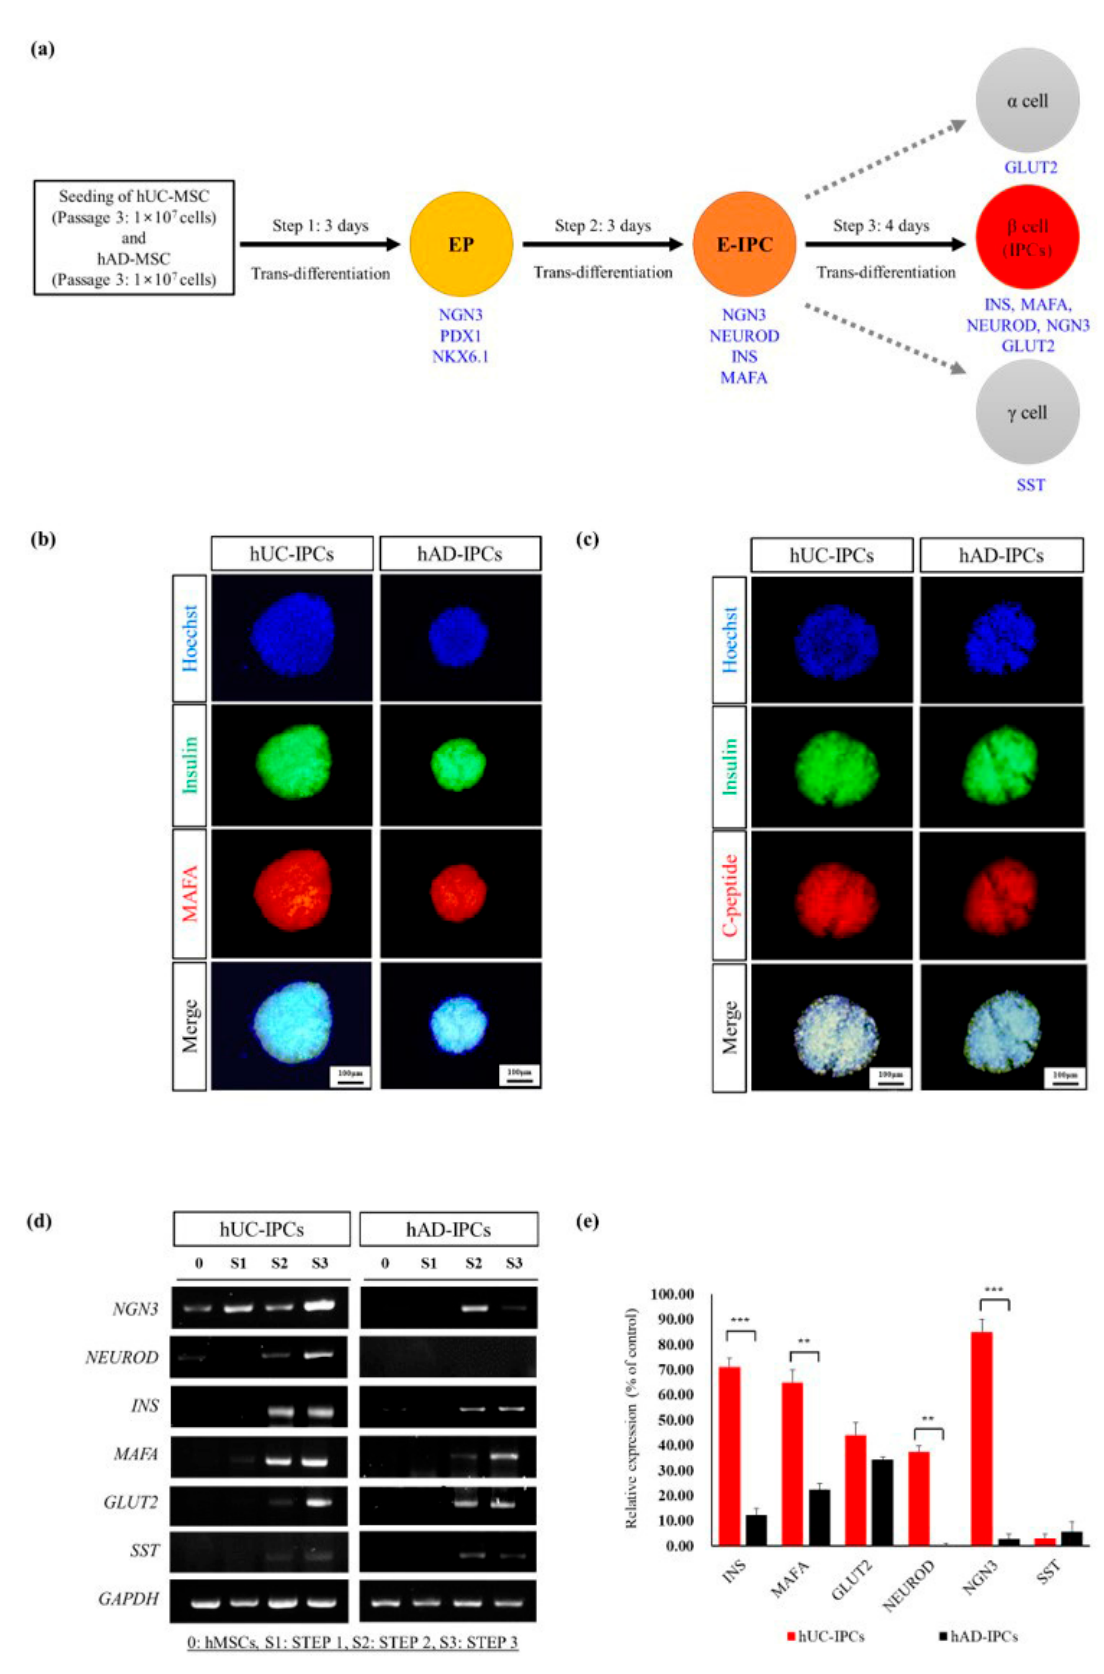
Figure 3. Trans-differentiation of mesenchymal stem cells. ( a ) The trans-differentiation protocol for obtaining pancreatic β -cells. Key transcription factor hierarchy during pancreas development. ( b )